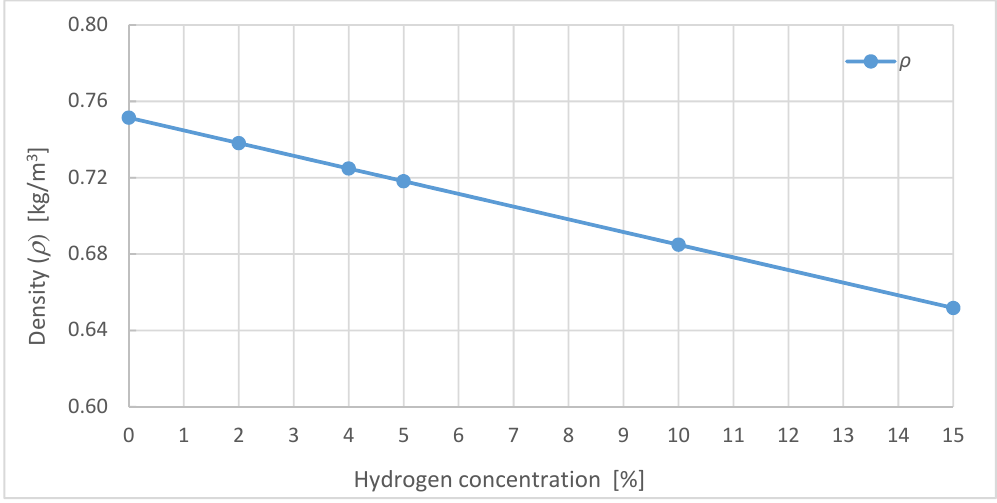
Figure 11. Density ( ρ ) of used gas mixtures.